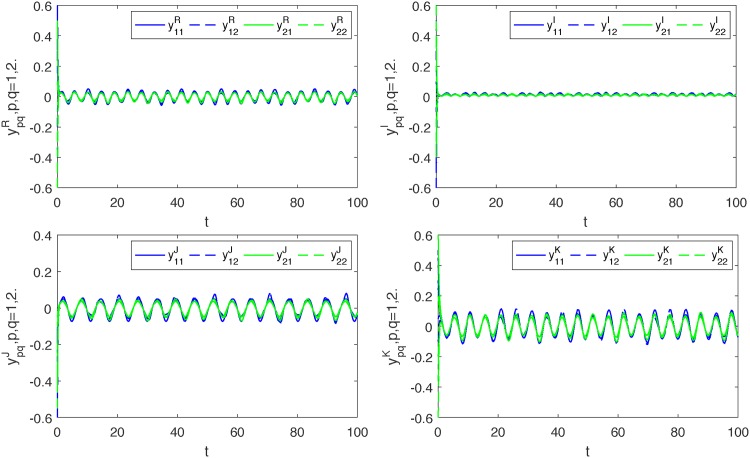
Transient states of four parts of ypq, p, q = 1, 2.